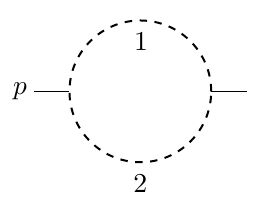
Figure 4 . Bubble graph: s = (cid:0) p 2